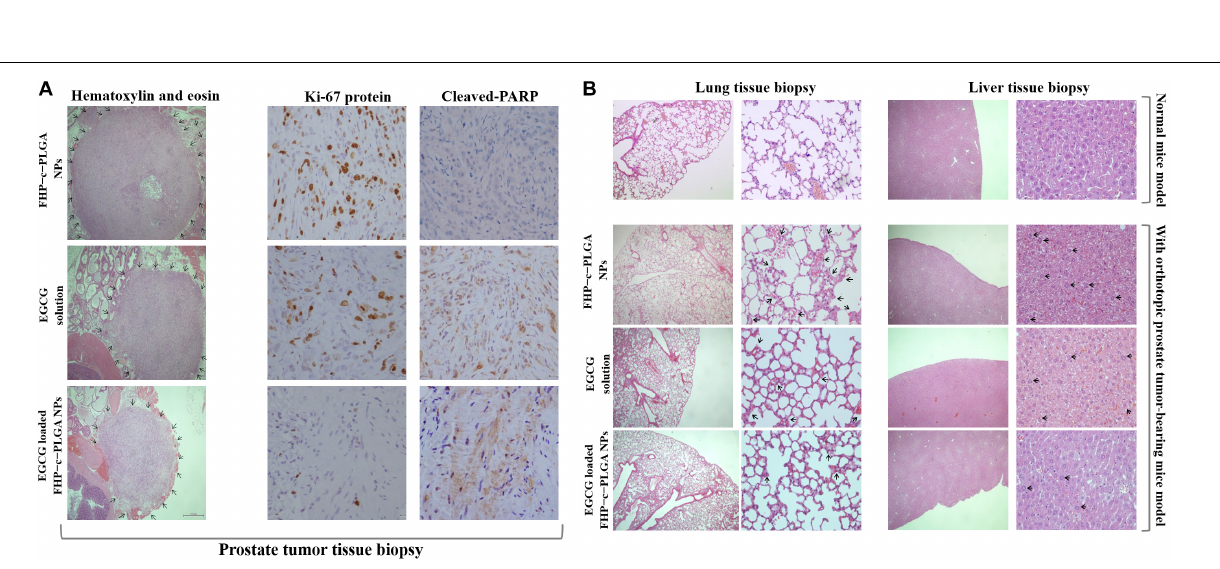
FIGURE 8 | Histological and immunohistochemical analyses of orthotopic prostate tumors treated with FHP ˝Uc ˝UPLGA NPs, EGCG solution, or EGCG-loaded FHP ˝Uc ˝UPLGA NPs. (A) Prostate biopsy. The black arrows indicate the tumor range. (B) Lung and liver biopsies. The black arrows indicate the inflammation.